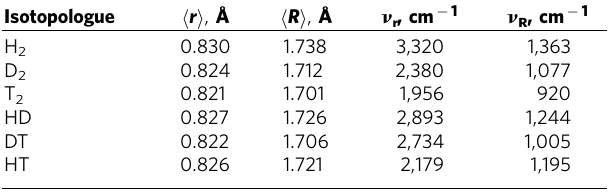
Table 1 | Expectation values and frequencies Isotopologue